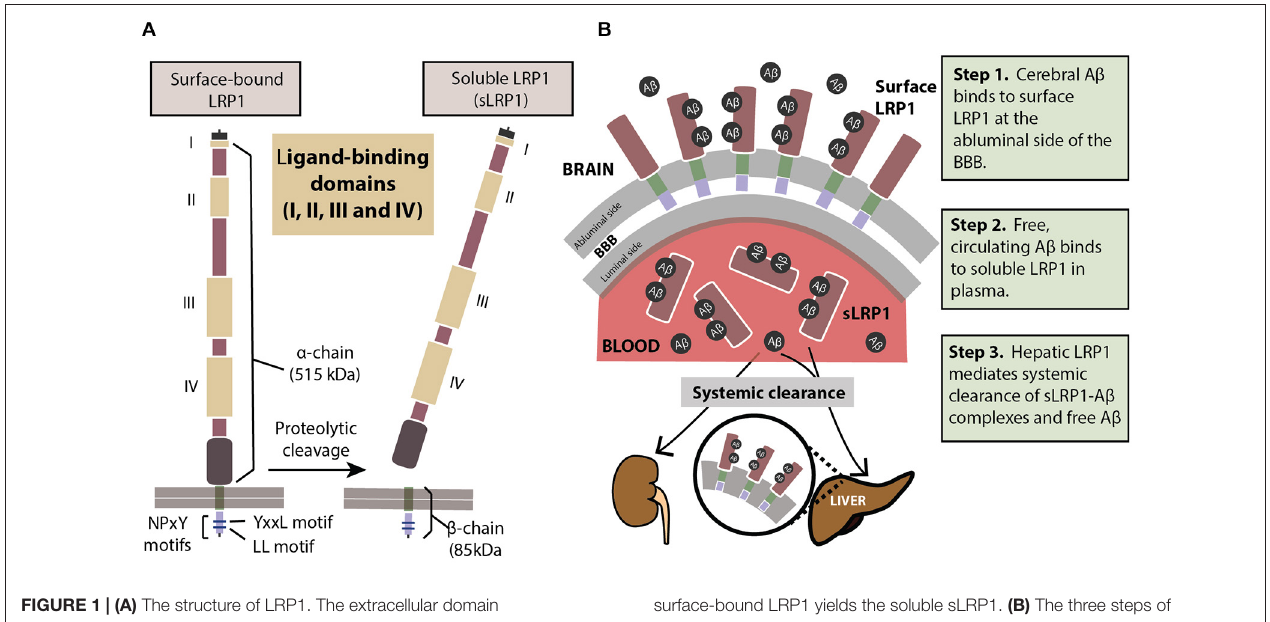
FIGURE 1 | (A) The structure of LRP1. The extracellular domain consists of a heavy α -chain (515 kDa) with four ligand-binding domains. The light chain or the β -chain (85 kDa) extends into the intracellular compartment where it has two characteristic NPxY motifs involved in endocytosis and cell signaling. Proteolytic cleavage of